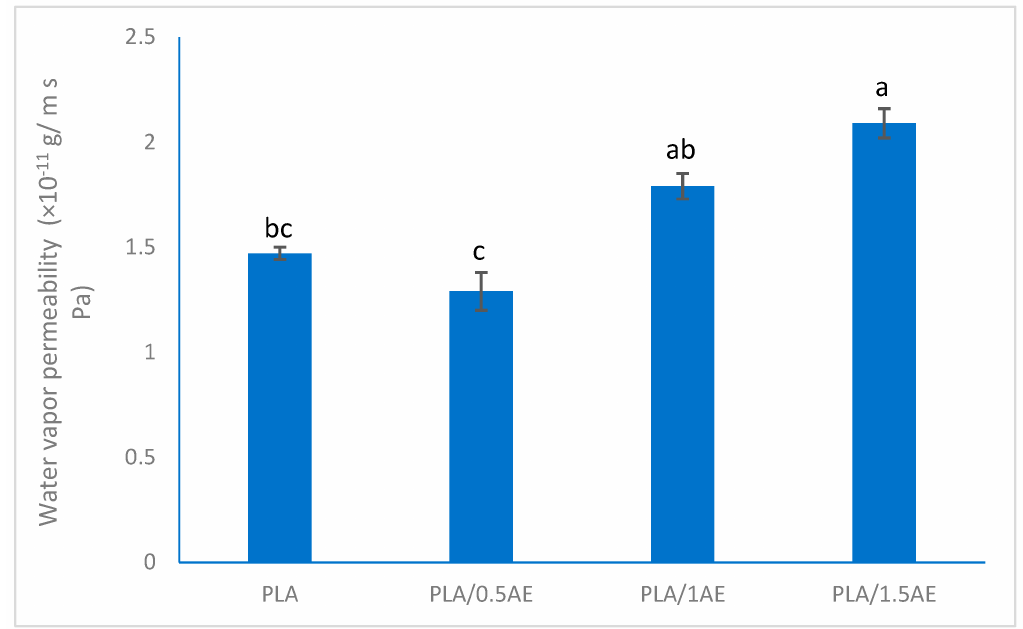
Figure 5. Water vapor permeability of poly lactic acid (PLA) films incorporated with anise essential oil (AE). Different lowercase letters indicate significant differences ( p < 0.05).